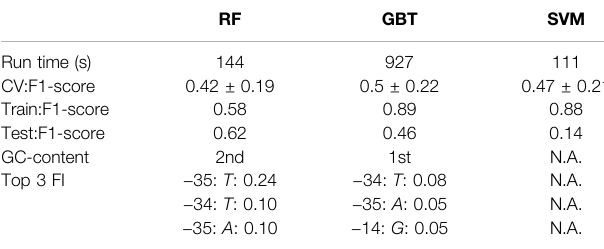
TABLE 1 | Classi fi cation quality report for random forest (RF), gradient boosting trees (GBT) and support vector machine (SVM). Run time re fl ects the computational time to train the respective machine-learning algorithm. CV:F1- score is the result of cross-validation performed 25 times with split 9:1 on the training data. Train/Test:F1-score , GC-content , and Top 3FI are results ofthe best respective estimator for training and test set F1-score, the importance of theGC-contentfeatureandthethremostimportantsequencepositionsalong with the importance values. The training was performed with the same Train(56)-Test(7) division with cross-validationon the training set (100 times 9: 1 split). Nucleotides included as features were fi ltered to contain at least an entropy of 0.2bits, which resulted in 15 positions, in addition to GC-content (input vector: 15 × 4 + 1). Only tree-based methods (RF, GBT) extract the feature importance